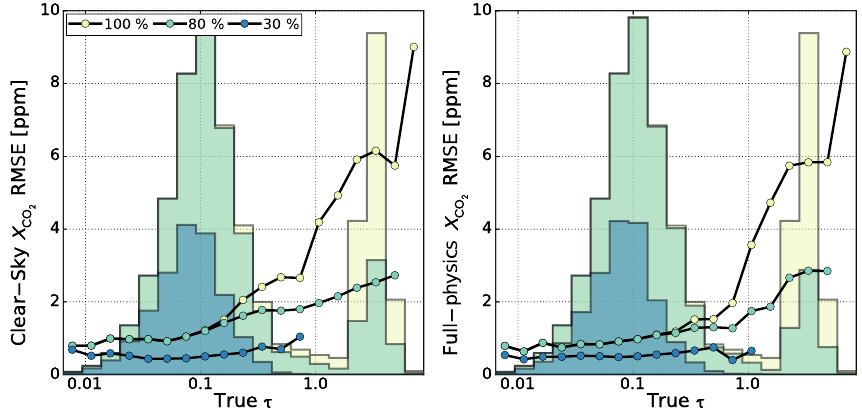
RMSEs vs. the true total optical depth for simulated OCO-2 measurements 2 RMSE for 100% throughput (yellow markers), 80% throughput (green markers), 2